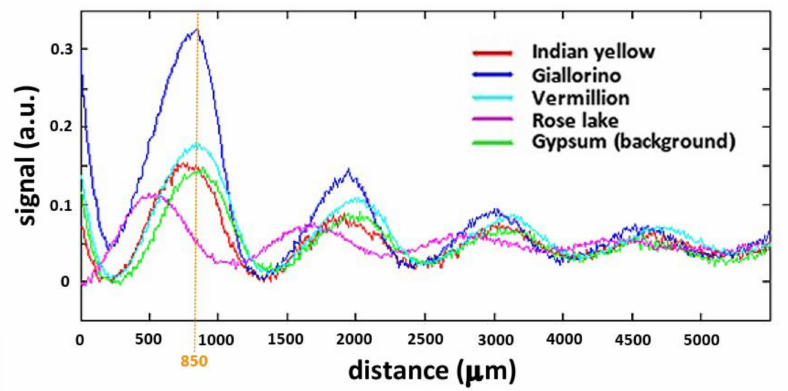
Figure 7. Phase profiles of di ff erent pigments and a determination of the optimal distance for imaging.